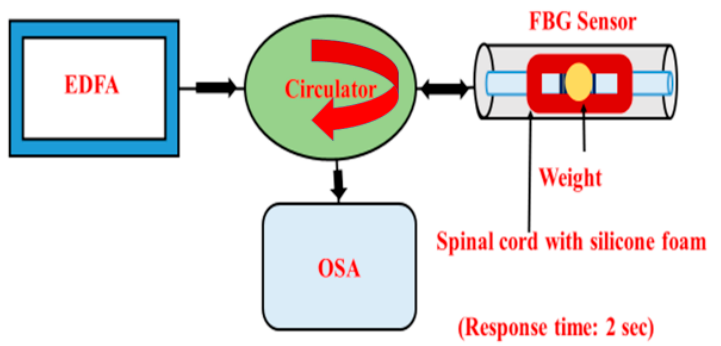
Figure 2. Experimental setup for the characterization of the fiber Bragg grating FBG sen- sor.